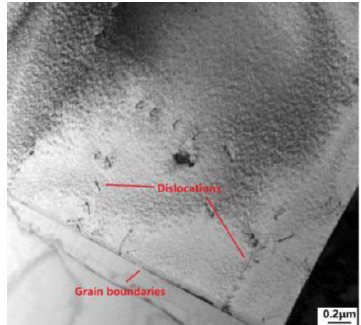
Figure 16. TEM of dislocation accumulation.